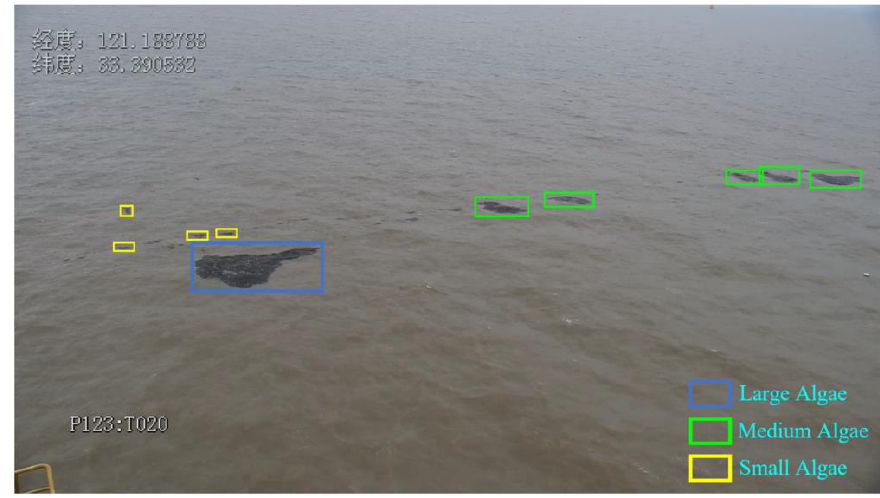
Figure 4. The visualization of large, medium and small size floating algae.